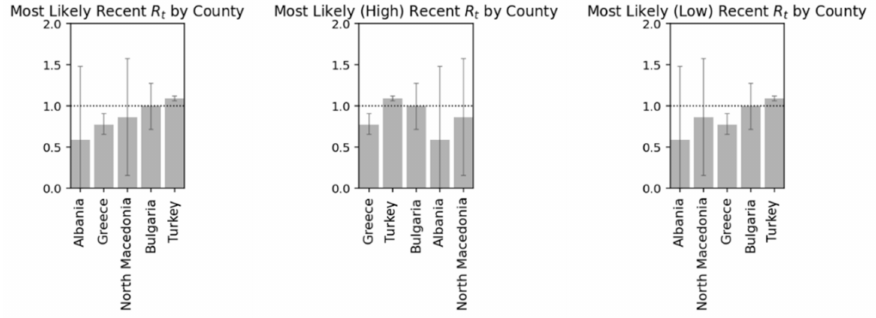
Figure 23. Most likely, high and low R t by country.